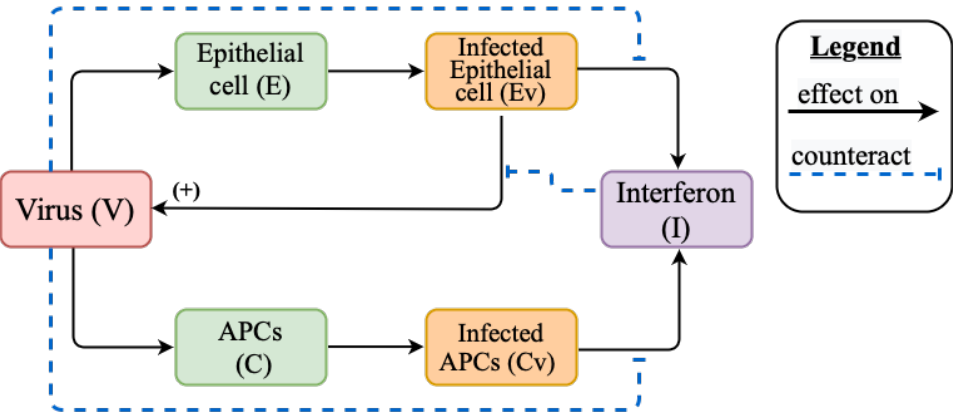
Figure A1. Schematic representation of the innate immune response to a viral respiratory infection. Green boxes indicate cells with constant presence in the organism. Orange boxes note virus-affected cells. Violet boxes show an induced immune